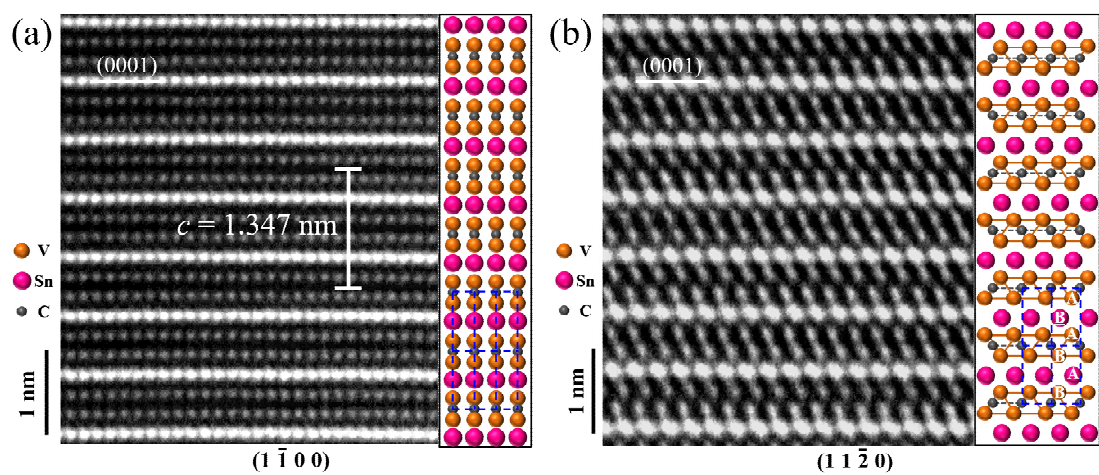
Fig. 5 Z -contrast STEM images of V 2 SnC on (a) (1100) and (b) (1120) planes. The insets are structure models representing the corresponding positions of V, Sn, and C atoms.